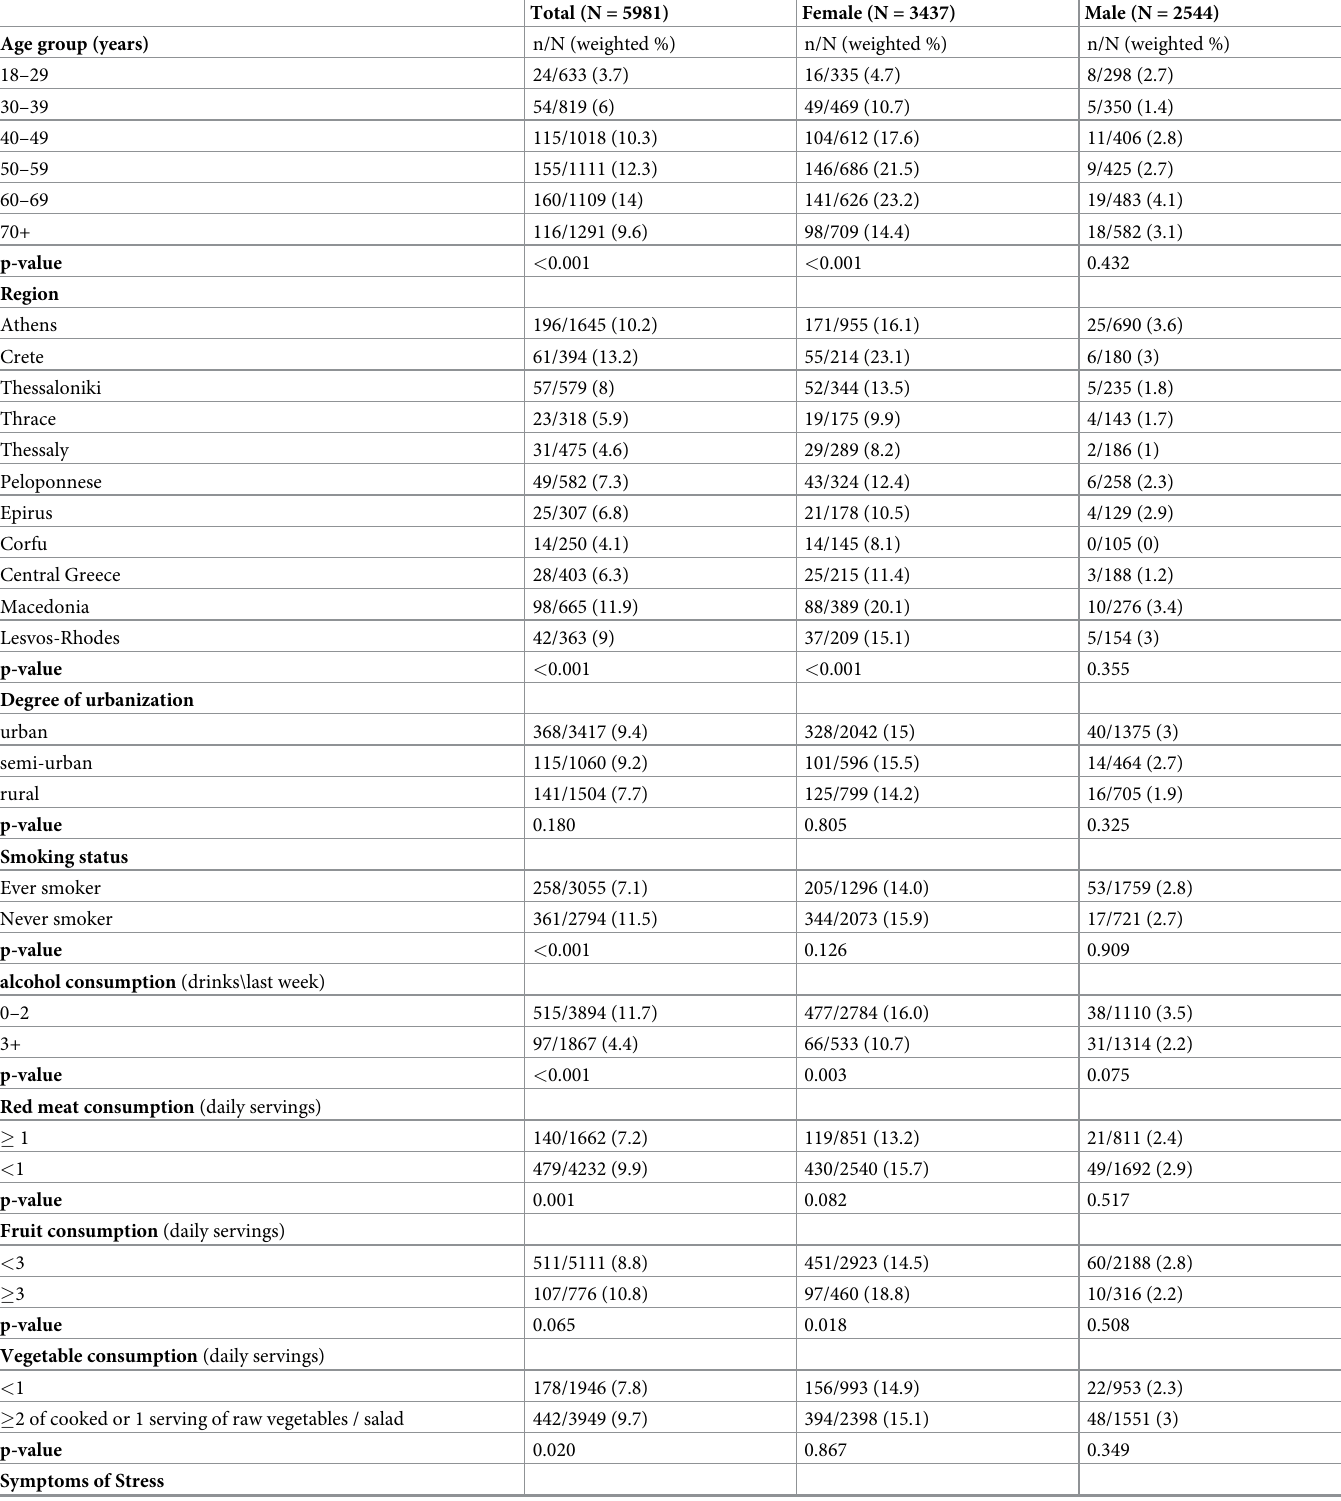
Table 1. Prevalence of thyroid disease overall and by